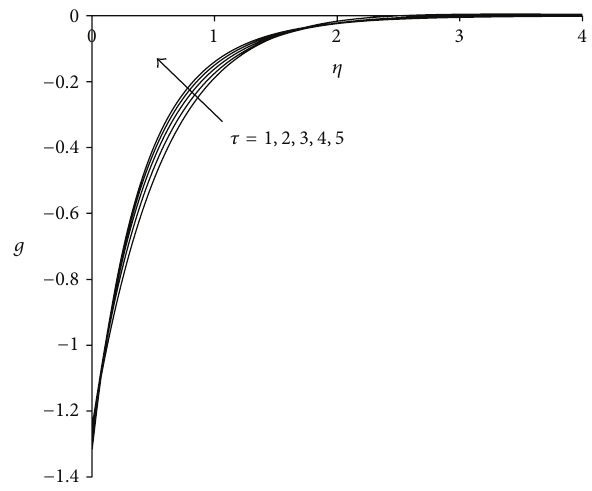
Figure 4: Temperature distribution for different 𝜆 (𝜏 = 1,𝜎 = 3, Ec = 0.75) .